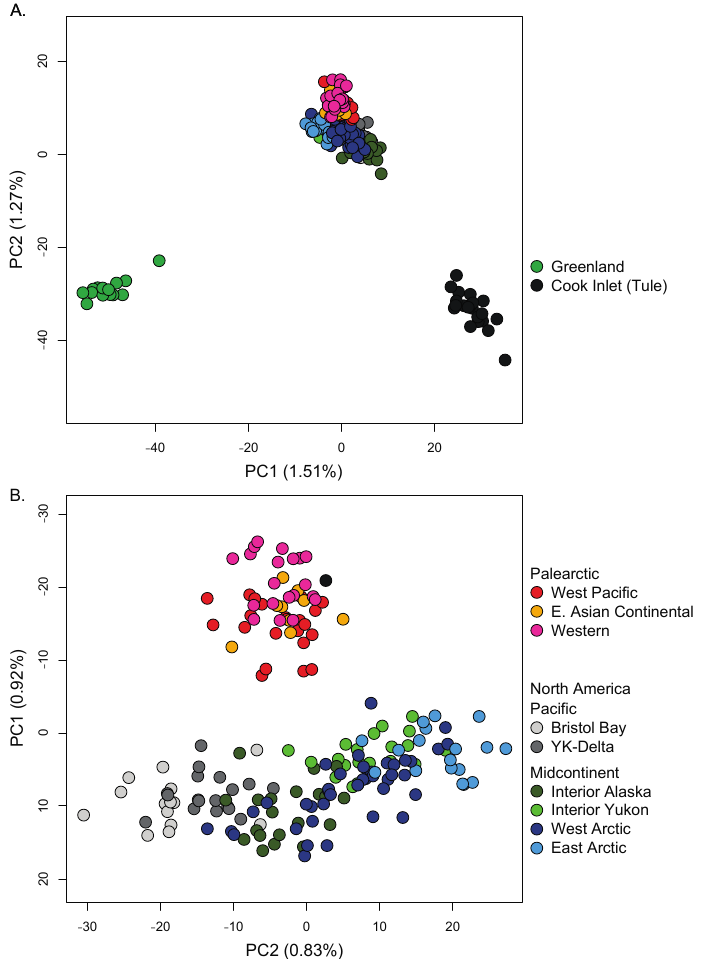
Figure 2. Results of principal components analysis for all samples ( A ) and with Cook Inlet and Greenland excluded ( B ). Analyses are based on 16,527 and 15,611 biallelic polymorphisms, respec- tively, drawn from 3888 ddRAD-seq loci. Note that PC2 is plotted on the x -axis in the lower figure to highlight the west to east arrangement of samples along that axis. PC3 in the second analysis (not shown) captures a similar east–west gradient among the Palearctic samples. Note the single sample from Cook Inlet with a Palearctic genotype (black point in lower figure). Colors of circles correspond to sampling localities/geographic regions as listed in Table 1.